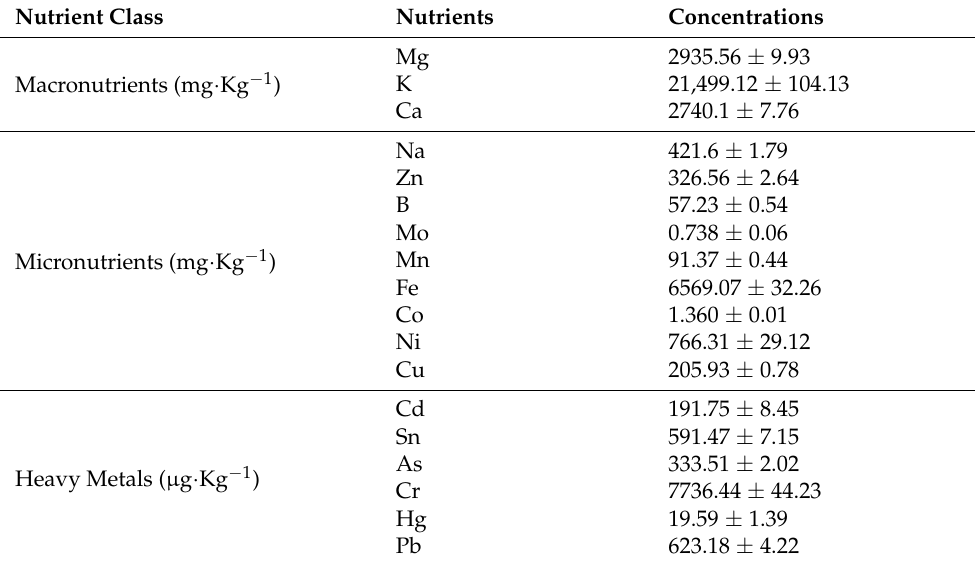
Table 1. Level of minerals and heavy metals in loquat growing soil before the foliar application of